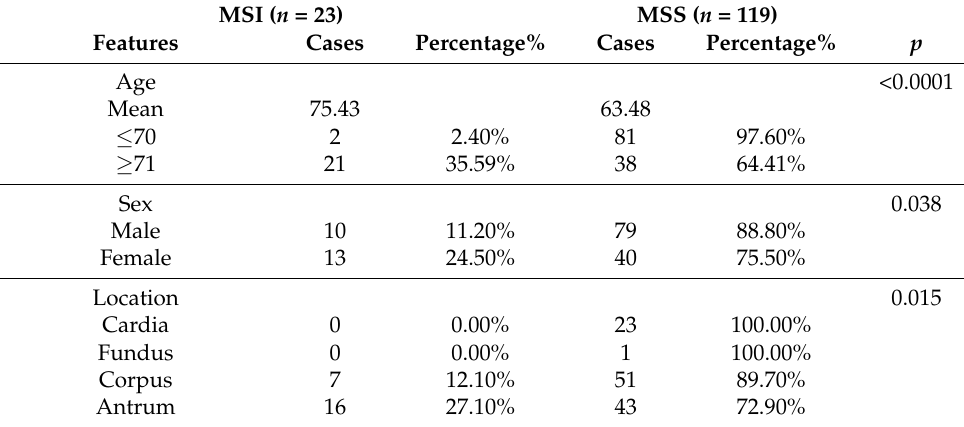
Figure 2. HER2-positive gastric cancer (Histoscore 3+). ( A , B ): Immunohistochemical technique show- ing intense basement membrane and basolateral staining in more than 10% of the cells (( A ), 100 × ; ( B ), 400 × )). Table 3. Clinical and pathological features of the 142 gastric cancer patients and correlation with MSI